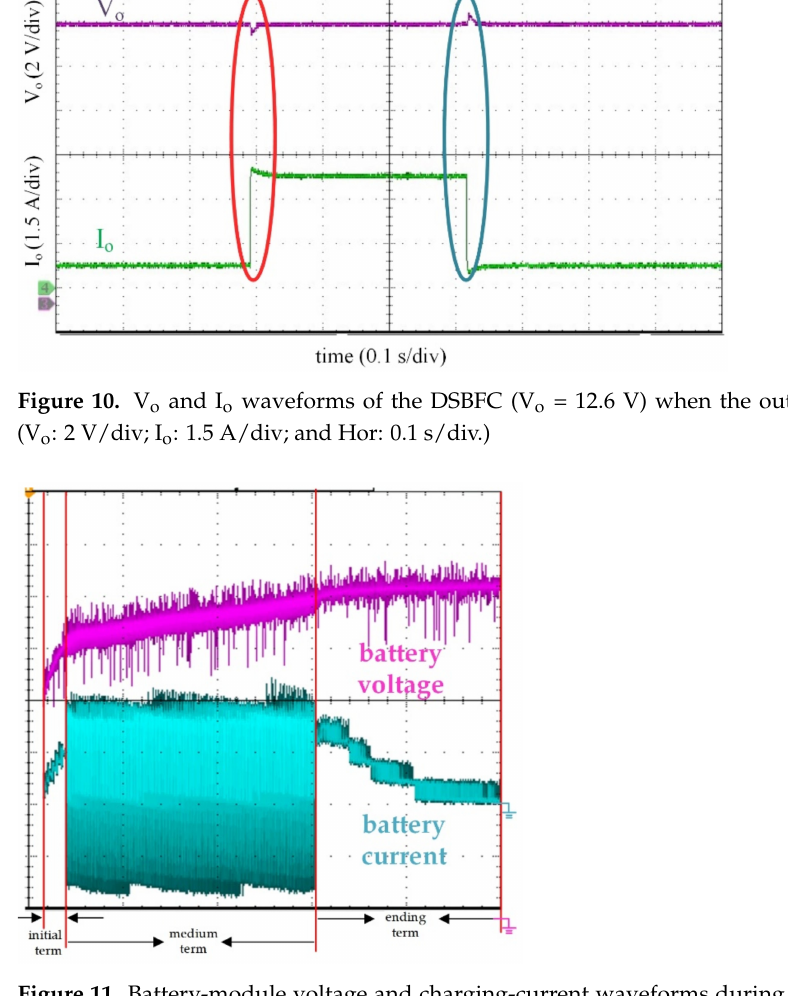
Figure 11. Battery-module voltage and charging-current waveforms during the charging process (Reflex-current charging method used in the mid-term.)